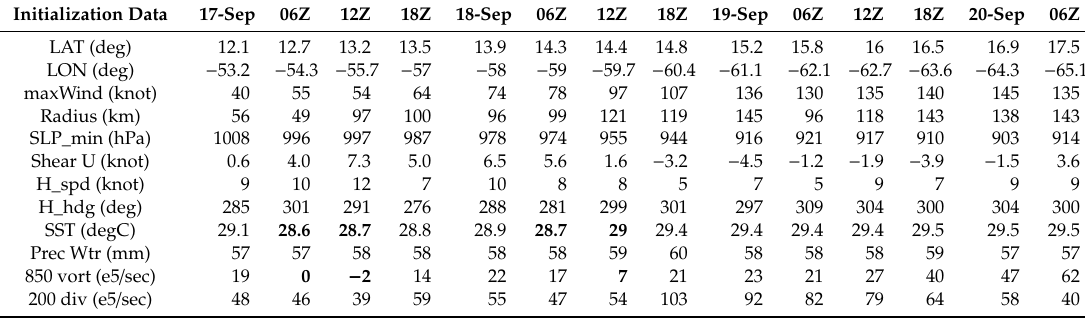
Table 3. Storm-following initialization data employed in COAMPS-CTCX forecasts. Bold numbers refer to low values of SST and 850 hPa